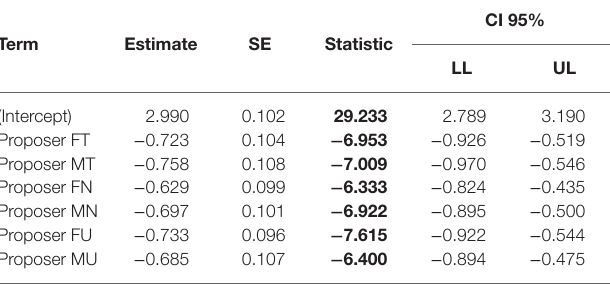
TABLE 3 | Fixed effects of proposers compared to baseline on RTs in the delay discounting task.